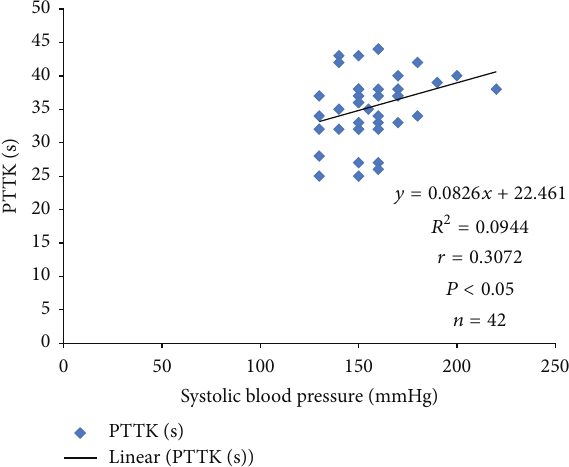
Figure 1: Correlation plot of diastolic blood pressure against dura- tion of illness in hypertensive patients.